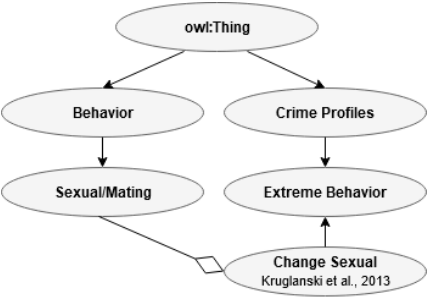
Figure 11. Relationship between sexual change related to EA (B) and the sexual change related to extreme behavior (CP).